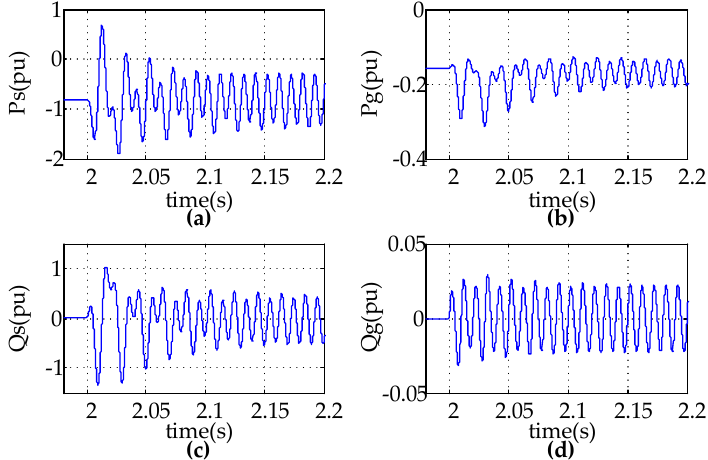
Figure 4. The output power of the DFIG system during grid voltage unbalance: ( a ) Stator active power; ( b ) Grid-side converter active power; ( c ) Stator reactive power; ( d ) Grid-side converter reactive power.